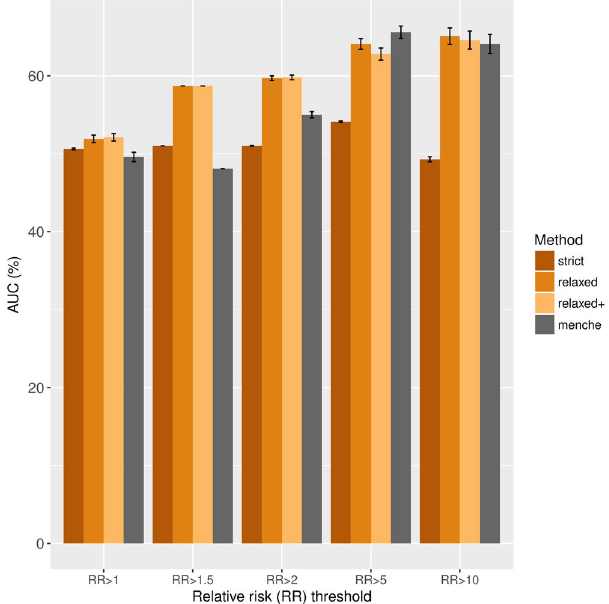
Figure 4. Prediction accuracy of composite score and network-based separation approach in characterizing disease comorbidities. The bars show the area under ROC curve (AUC) using the disease-disease associations reported previously by Hidalgo et al . 25 , at varying relative risk (RR) thresholds as the gold standard. For each RR threshold, we calculate the true positive rate and false positive rate over various prediction score cutoffs to generate a ROC curve and find the area under ROC curve. We randomly sample among the unknown (negative) associations to balance the number of positive associations with the number of negative associations and repeat the procedure 100 times to have robust estimates for mean AUC. The bars represent mean AUC and the error bar correspond to the standard error over 100 runs. The measures are the composite score calculated using genetic and functional overlap based on strict and relaxed criteria, their combination (relaxed + ) or the interactome based separation measure introduced recently 15